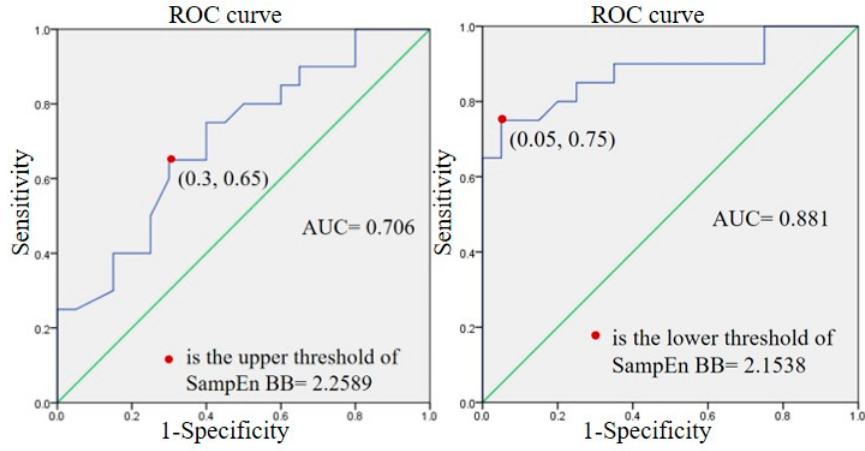
Figure 7. The results for SampEn BB ROC curve.